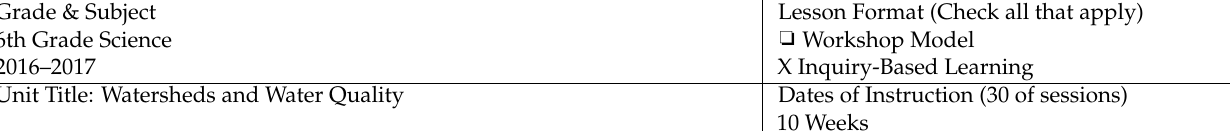
Table A1. Avenue School Unit Plan, Page 1.